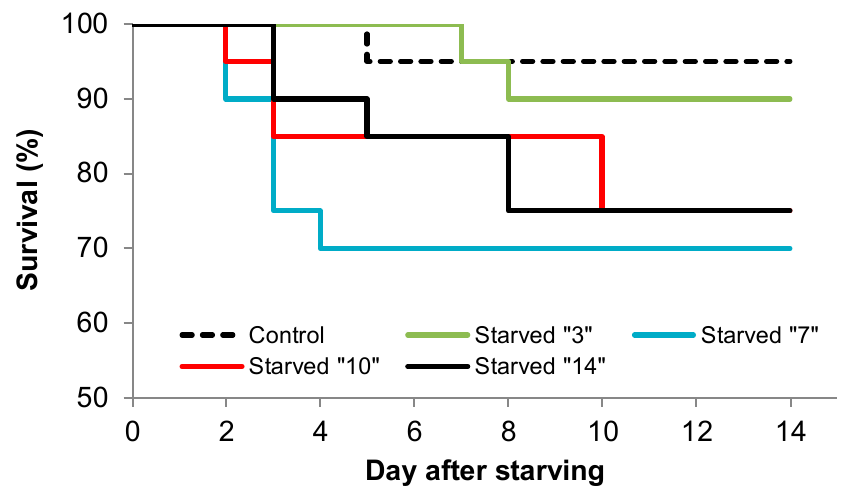
Figure 3. The survival (log-rank test; p < 0.1716) of L3 pine-tree lappet Dendrolimus pini larvae fed ad libitum (control) and for four variants of breeding, i.e., starved for 3, 7, 10, and 14 days and then fed ad libitum for the next 14 days. Survival during the periods in which the larvae were subjected to starvation is not shown in the figure. Only surviving larvae were taken to observe the recovery phenomenon.